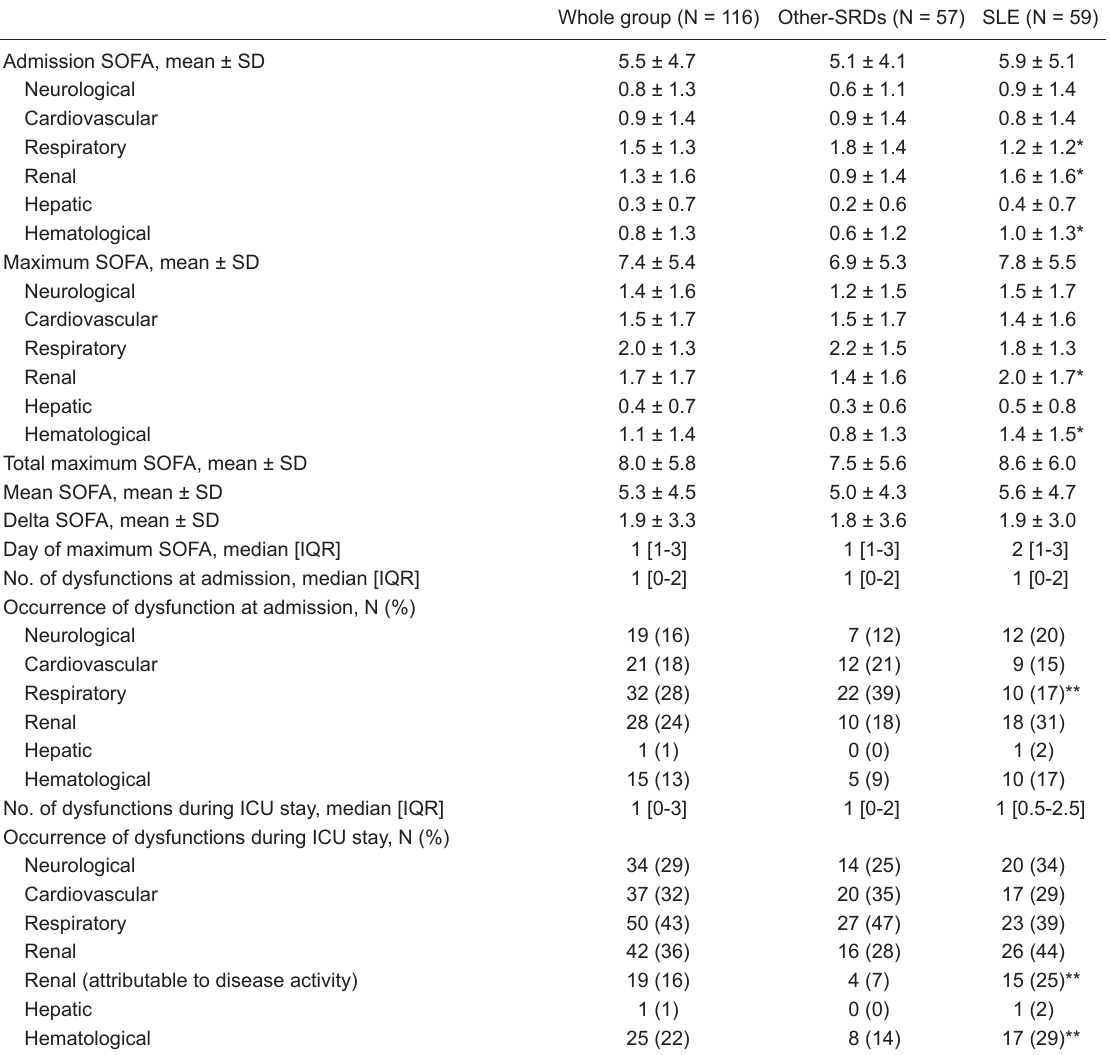
Table 4. Characterization of organ dysfunctions using the SOFA score at admission and during the ICU